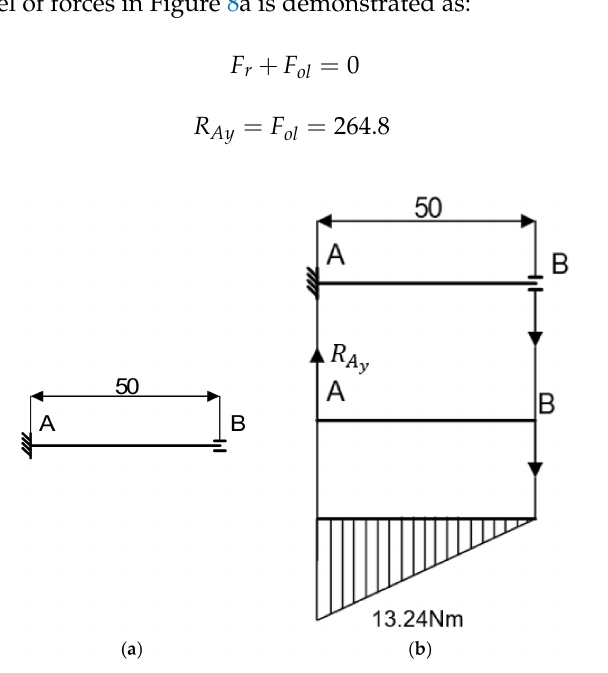
Figure 8. Analysis of joint 2: ( a ) model of forces, ( b ) distribution of